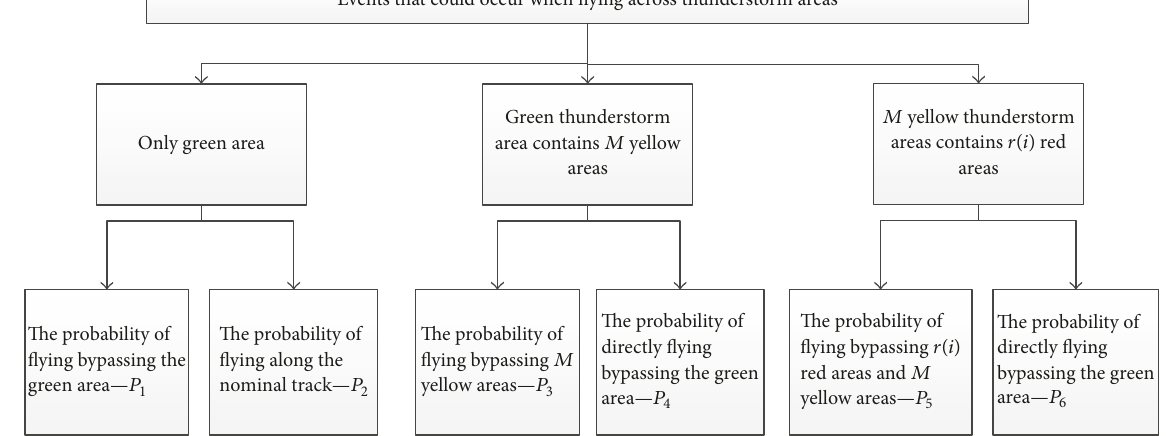
Figure 5: Conditions when a leg passes through a restricted thunderstorm